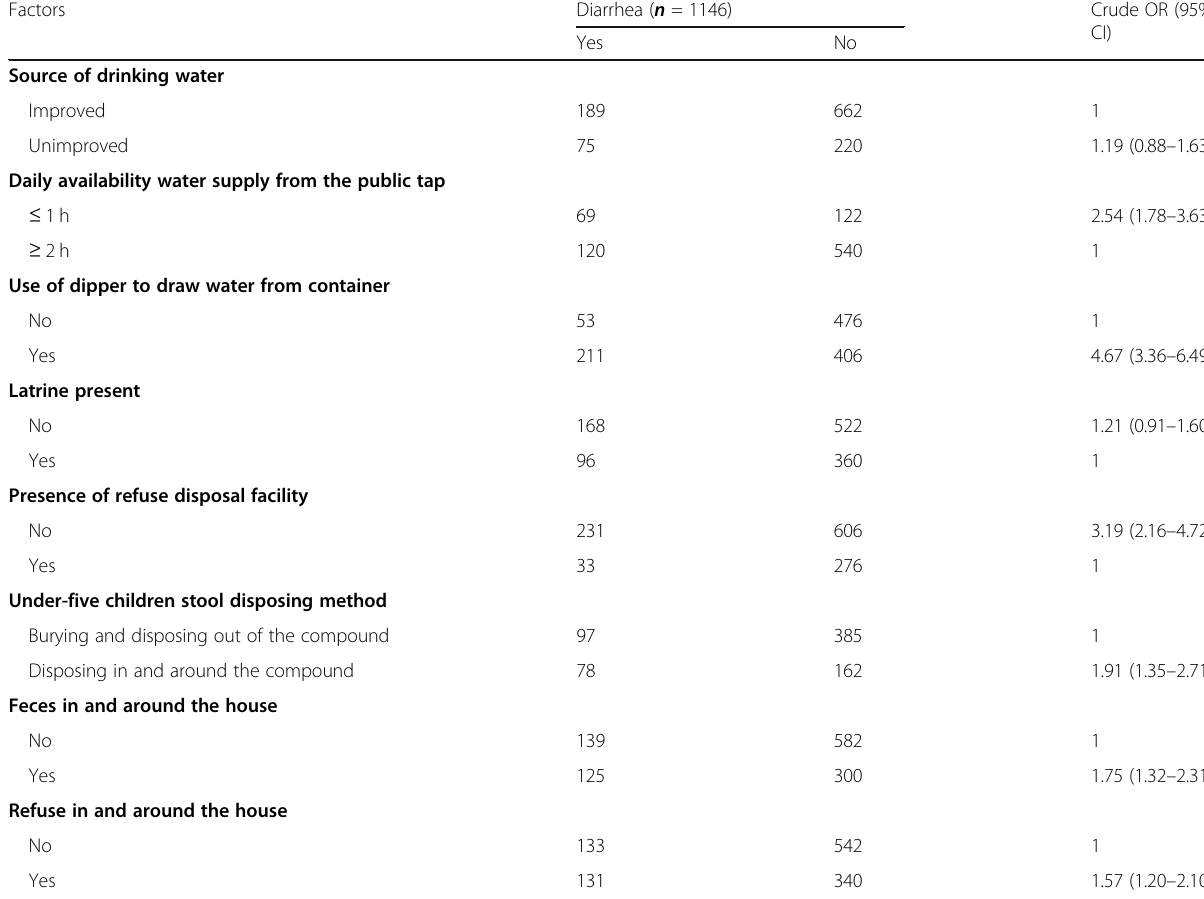
Table 4 Distribution of diarrheal disease in relation to environmental factors, rural Dire Dawa, Eastern Ethiopia, 2018